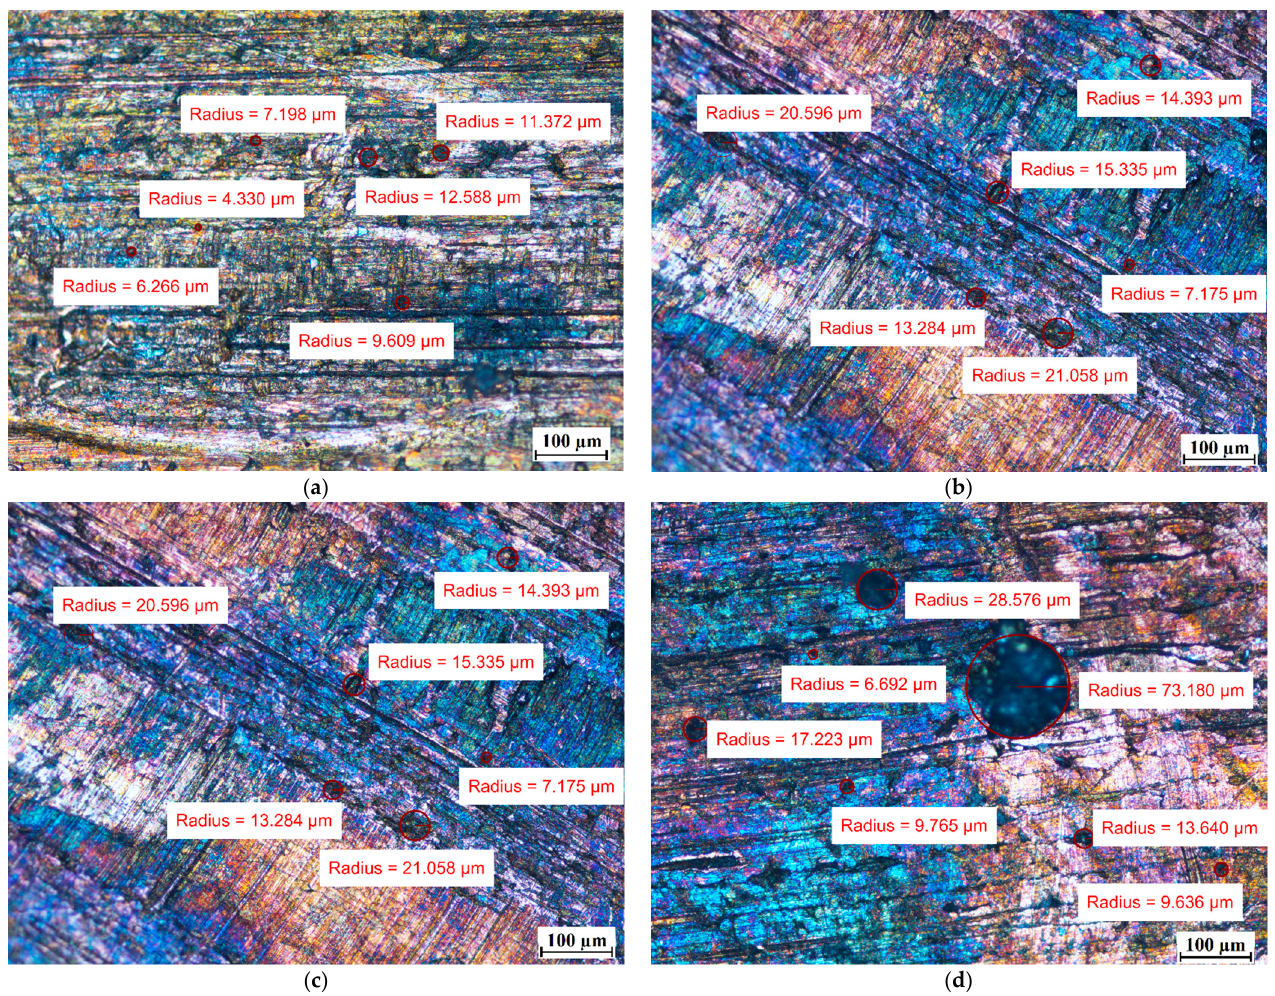
Figure 8. The surface of the copper samples (Cu) ( a ) before immersion in PCM; ( b ) after 7 weeks immersion in RT15; ( c ) after 7 weeks immersion in RT18 HC; and ( d ) after 7 weeks immersion in RT22 HC.